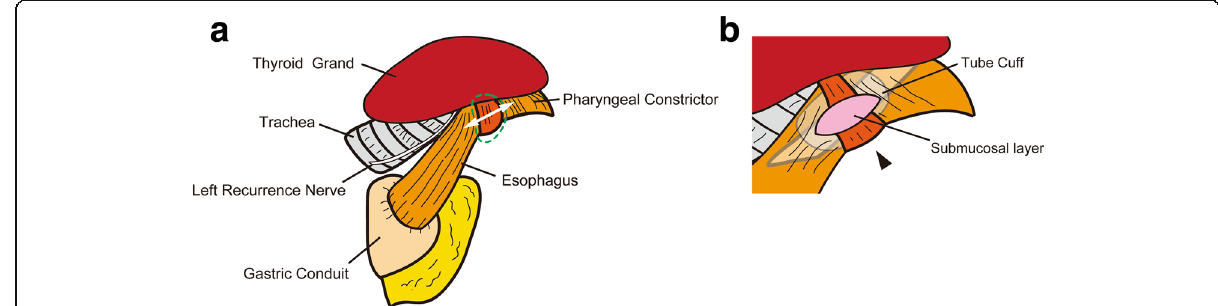
Fig. 3 Schematic of cricopharyngeal myotomy. a Fibrosis occurred in the cricopharyngeus muscle (green dots). The resection line (white line) was demonstrated lateral cricopharyngeus muscle. b When the bilateral cricopharyngeus muscles (arrow) were resected, a disposable